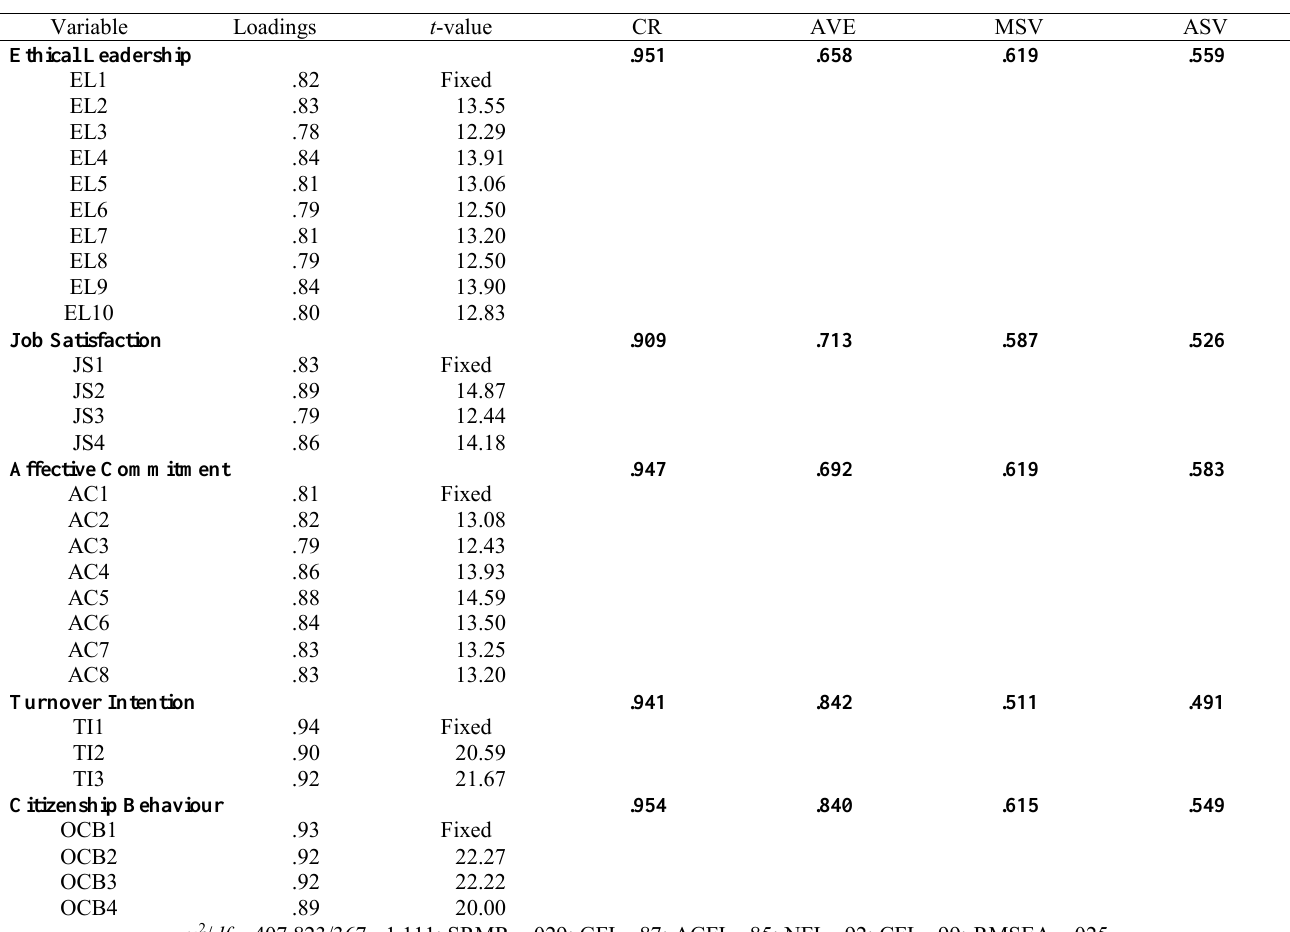
Table 3: Description statistics of CFA analysis